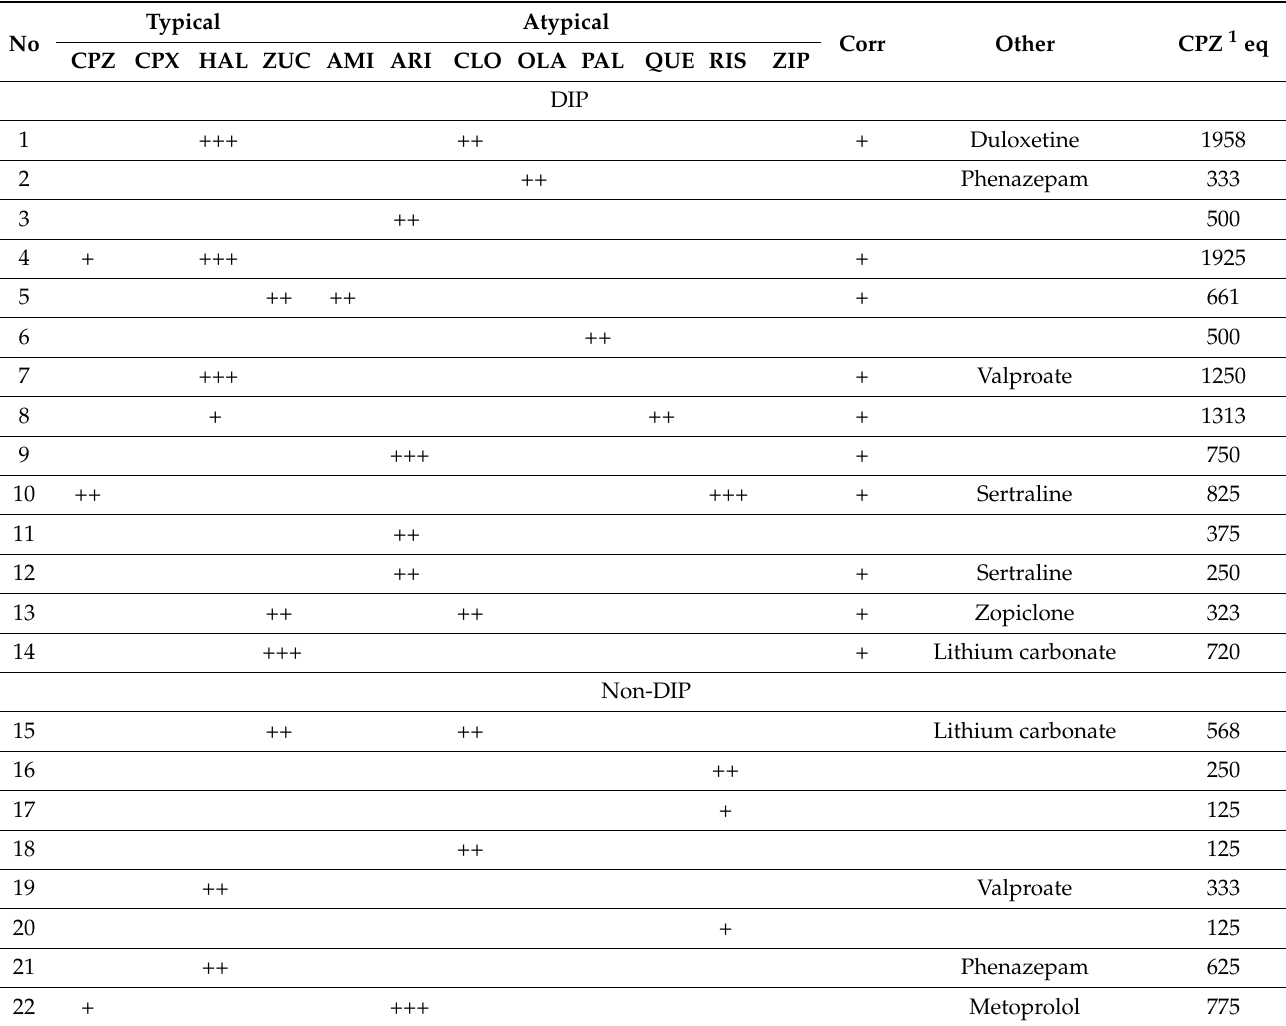
Table A1. Pharmacological